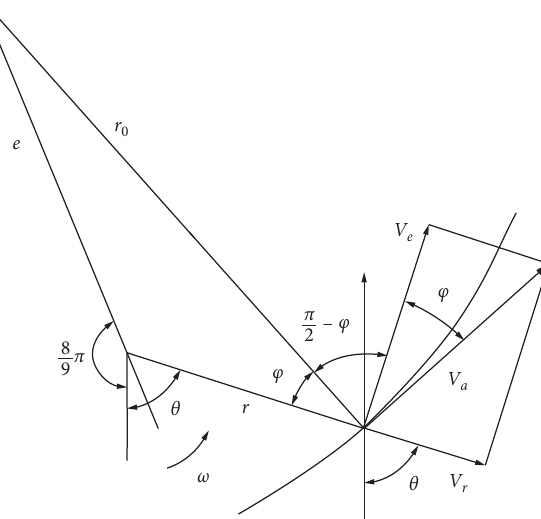
Figure 7: Analysis of cotton seed movement